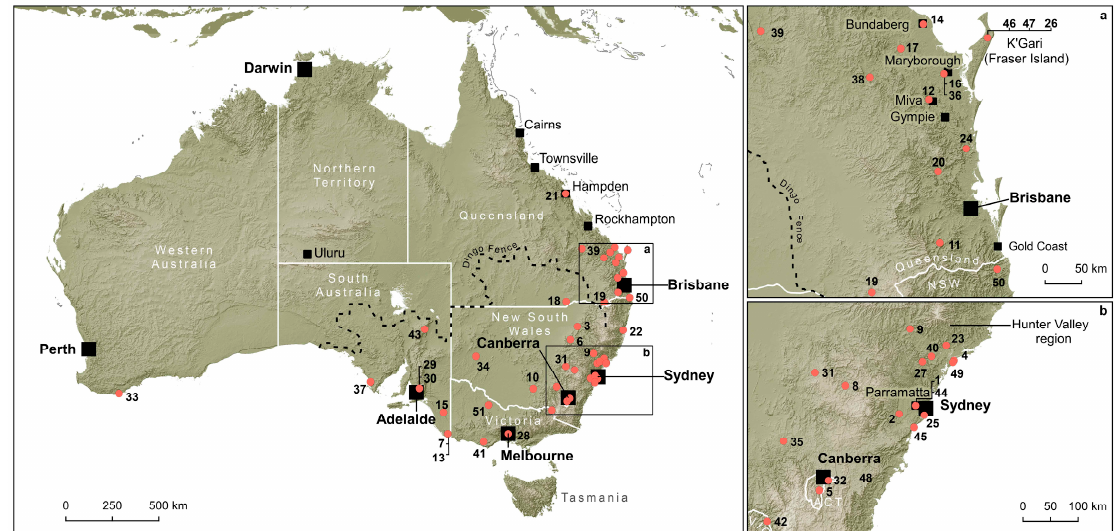
Figure 2. Map showing the distribution of historical accounts of wild dingo attacks. The locations of the historical dingo attacks are represented by the enumerated red dots. The broken line denotes the dingo barrier fence (‘Dingo Fence’), established in the mid-20th century to keep dingoes out of